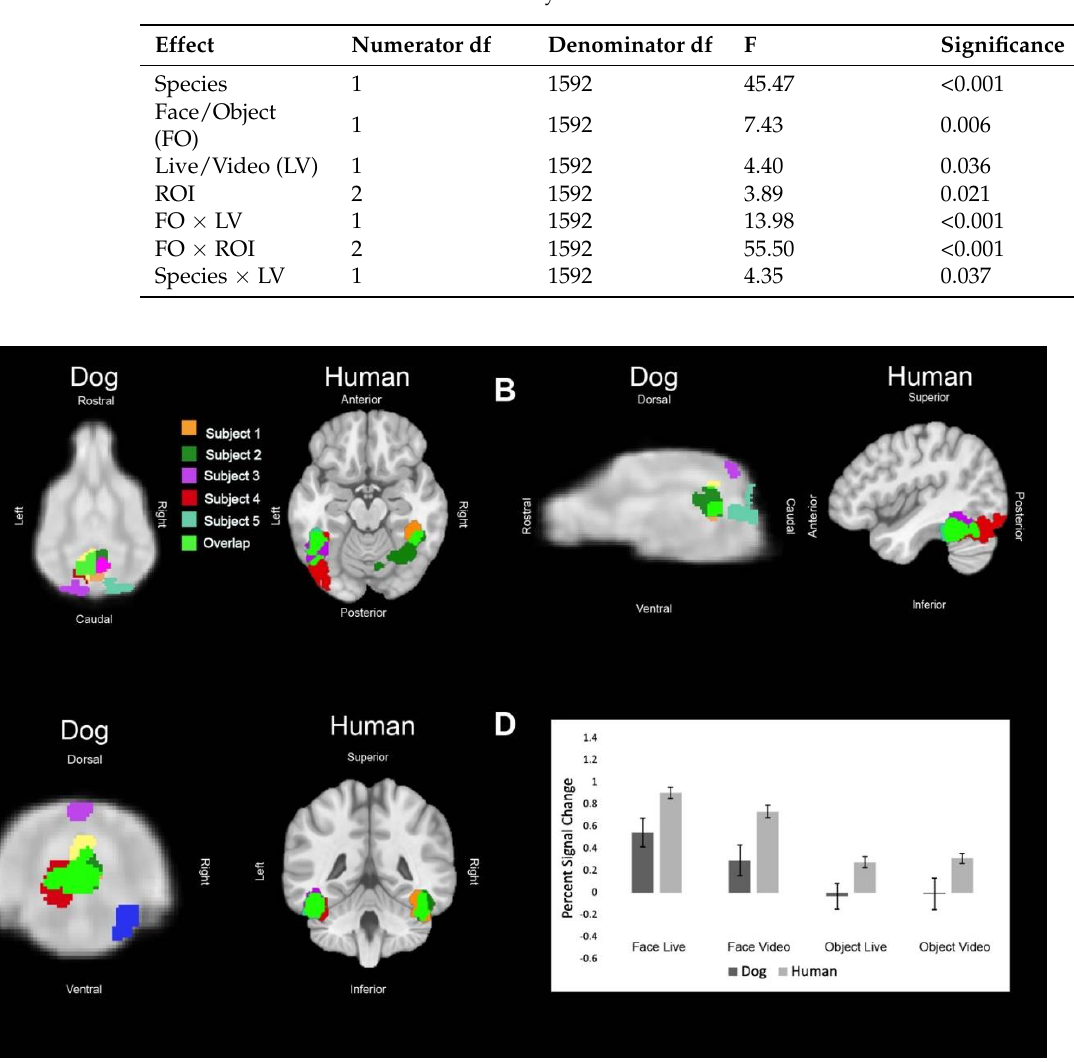
Figure 2. Definition and activations within the primary dog face area and human fusiform face area. For visualization purposes, these regions of interest have been spatially normalized and overlaid on to their respective atlases (humans: Montreal Neurological Institute atlas [21]; dogs: CCI atlas [22]). Each color represents the ROI of one dog or human or an area where the regions of interest overlapped. ( A ) Dorsal (dog) and axial (human) views of individual ROIs. ( B ) Sagittal views. ( C ) Transverse (dog) and coronal (human) views. ( D ) The bar graph shows the average percent signal change for each species for each condition relative to the implicit baseline. Error bars are the standard